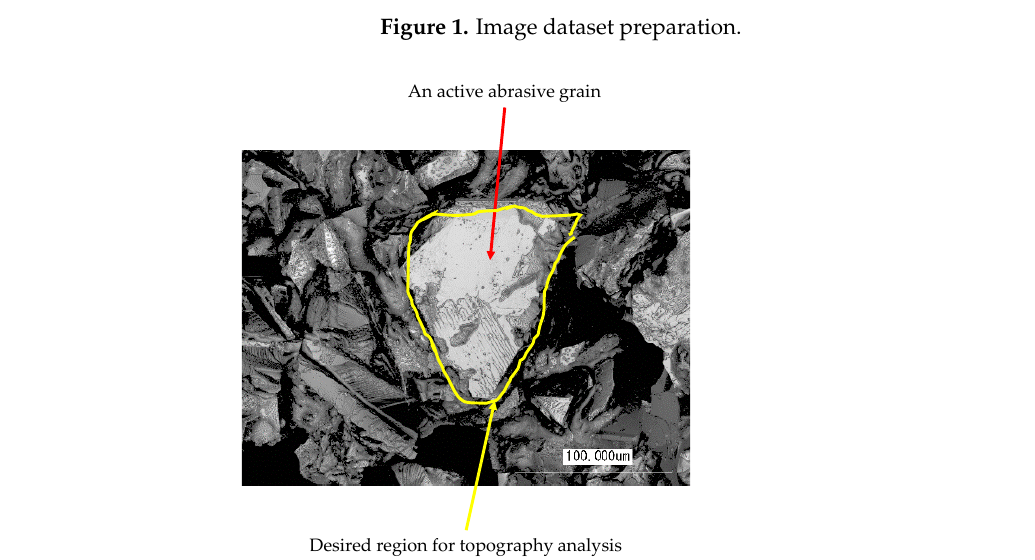
Figure 2. Image of an active abrasive grain and its vicinity.